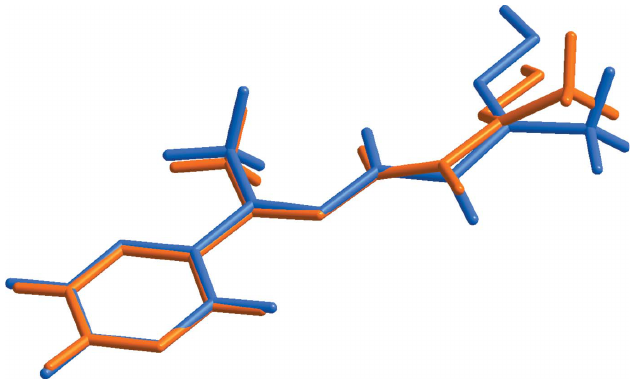
Figure 4 A view of the two-dimensional fingerprint plots for the title compound 1 showing ( a ) all interactions, and delineated into ( b ) H (cid:2)(cid:2)(cid:2) H (41.9%), ( c ) N (cid:2)(cid:2)(cid:2) H/H (cid:2)(cid:2)(cid:2) N (20.5%) and ( d ) O (cid:2)(cid:2)(cid:2) H/H (cid:2)(cid:2)(cid:2) O (15.4%) contacts.